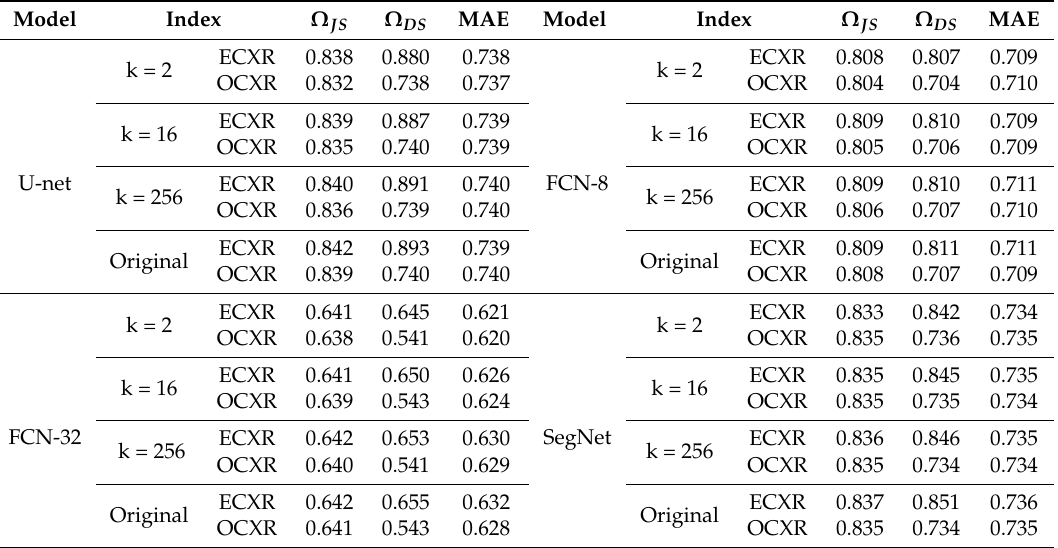
Table 1. The segmentation accuracy (measured using Jaccard, Dice, and MAE metrics) of the often-used segmentation models using different pixel